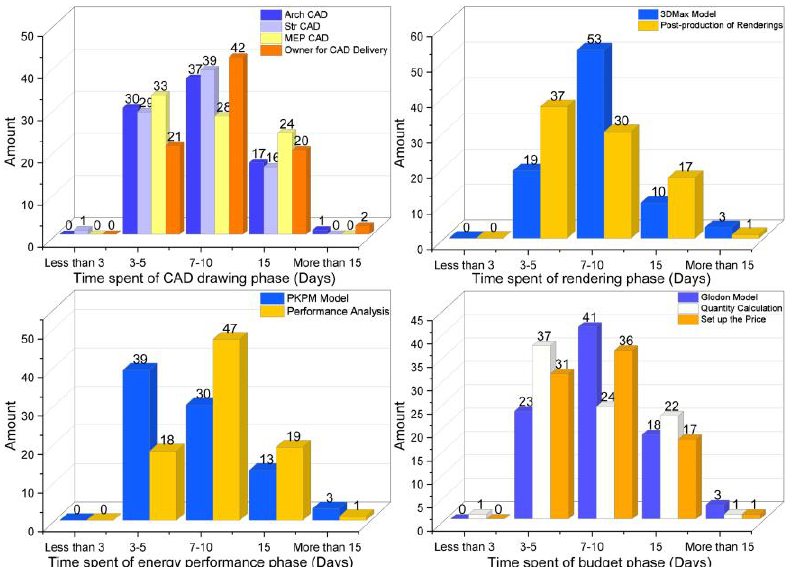
Figure 5. Questionnaire feedback on traditional workflow.